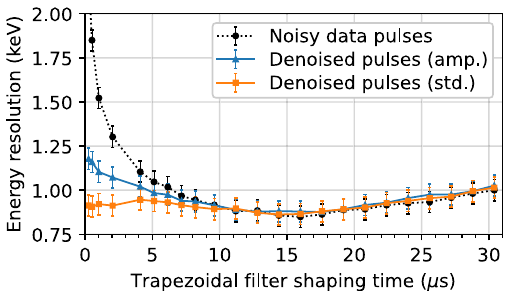
Fig. 10 χ 2 distribution computed between the data and both the denoised pulse (slanted line hatch) and best fit library pulse (dotted hatch)